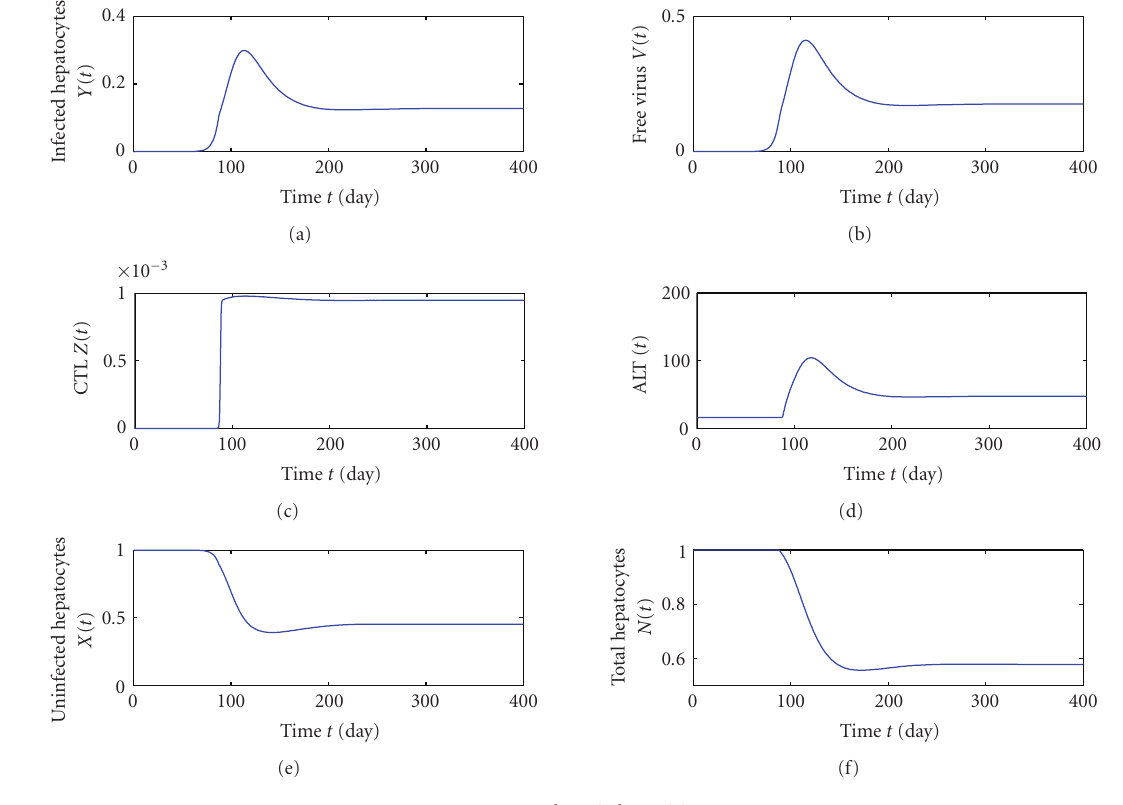
Figure 4: Chronic